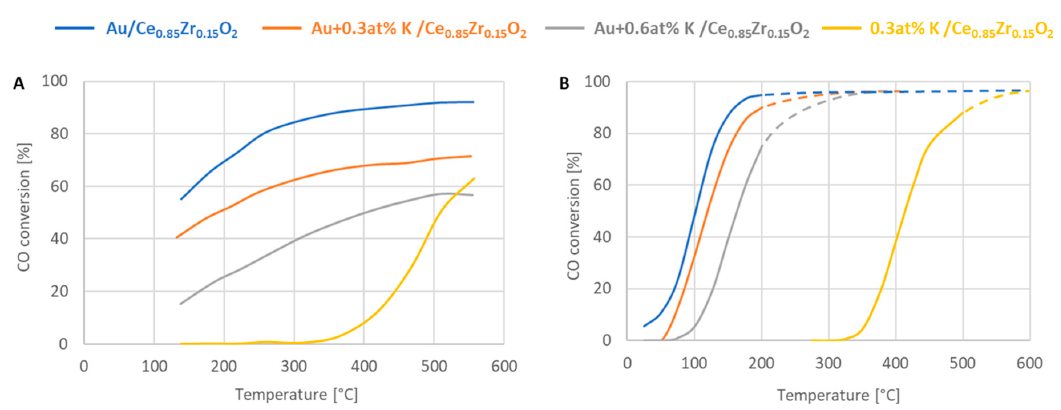
Figure 5. Conversion of carbon monoxide in ( A ) activity tests in the multicomponent stream and ( B ) the stream with 1 vol% CO + 1 vol% O 2 in He, on the gold catalysts and potassium-doped support.